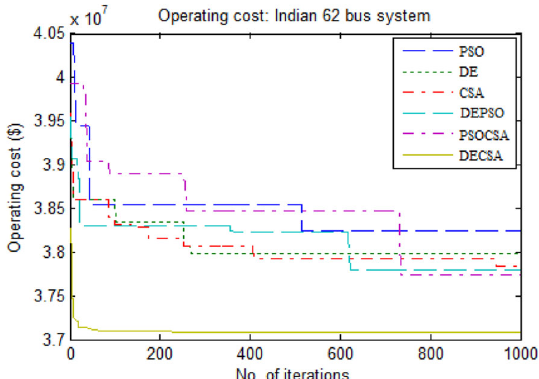
Fig. 5 Convergence behavior of OC from respective algorithms